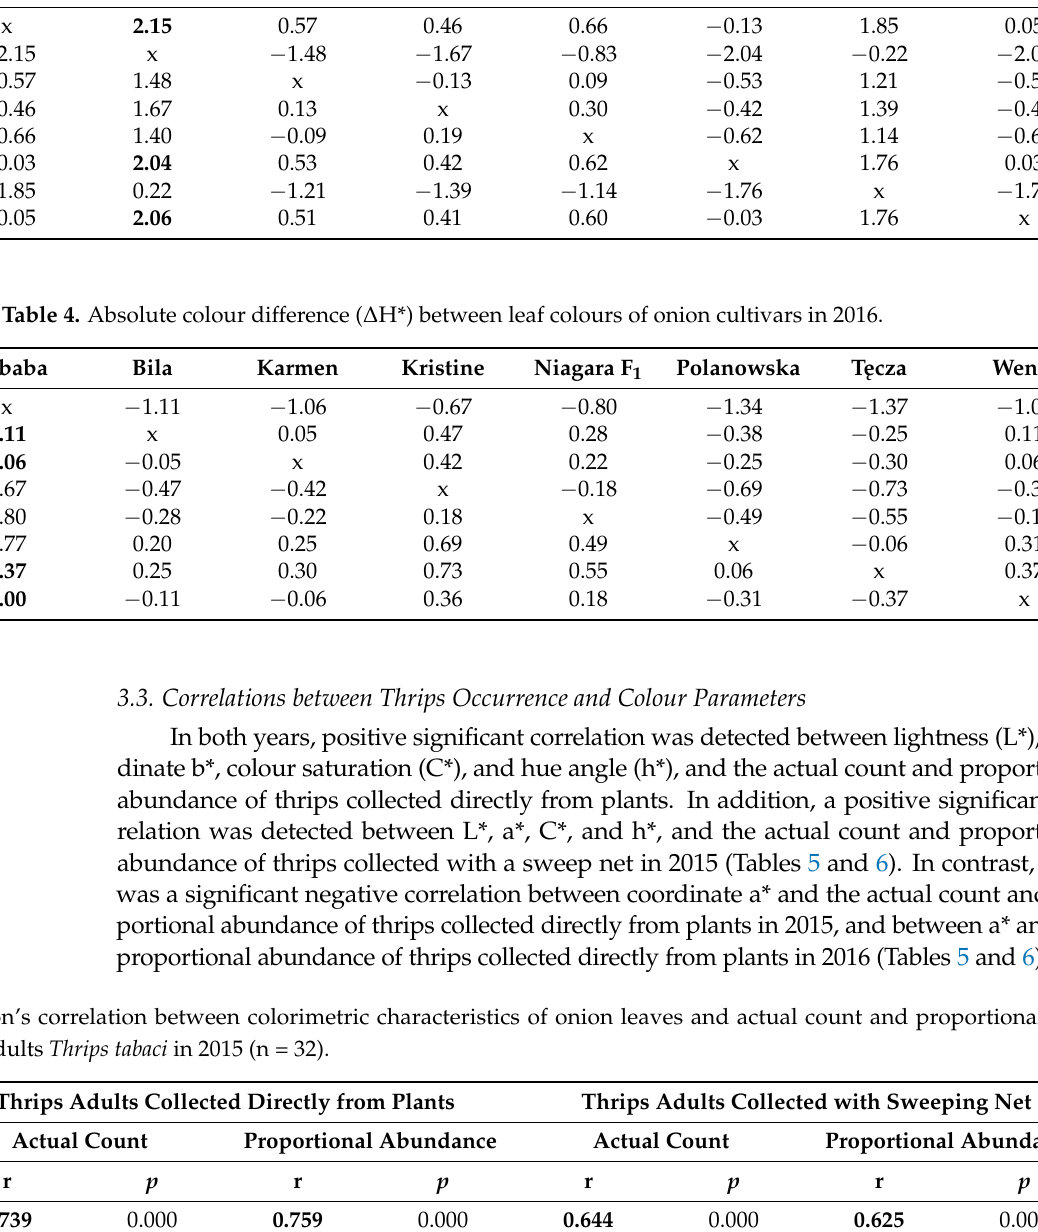
Table 3. Absolute colour difference ( ∆ H*) between leaf colours of onion cultivars in 2015. Cultivar